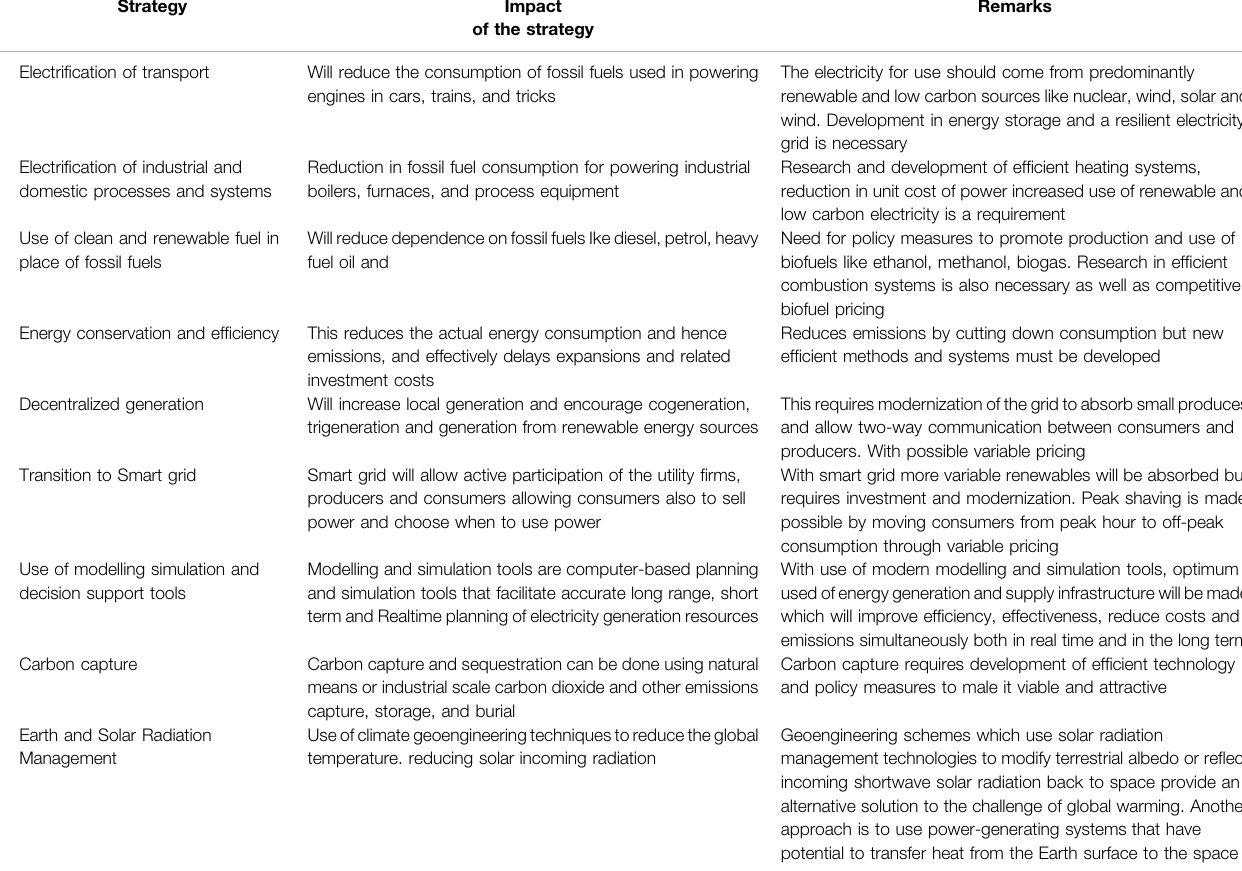
TABLE 6 | Summary of sustainable energy transition strategies.